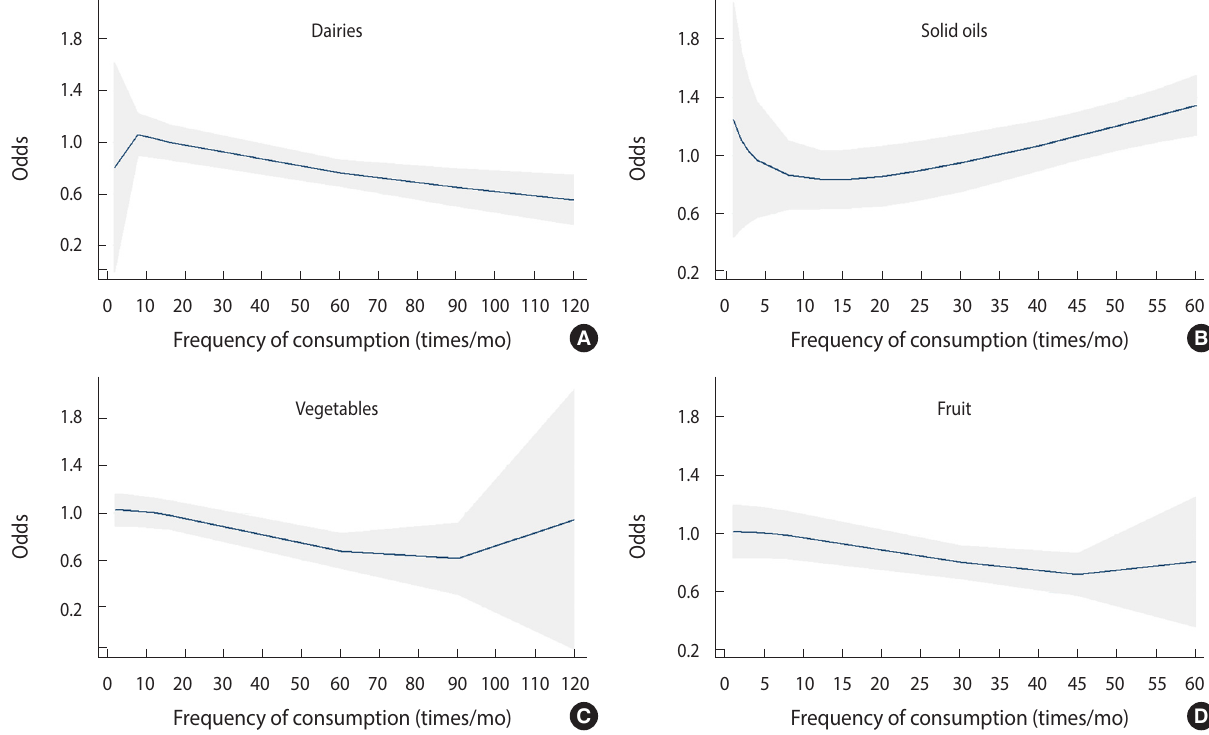
Figure 3. The odds of breast cancer associated with the consumption of (A) dairy products, (B) fats and oils, (C) vegetables, and (D) fruits in terms of the frequency of consumption